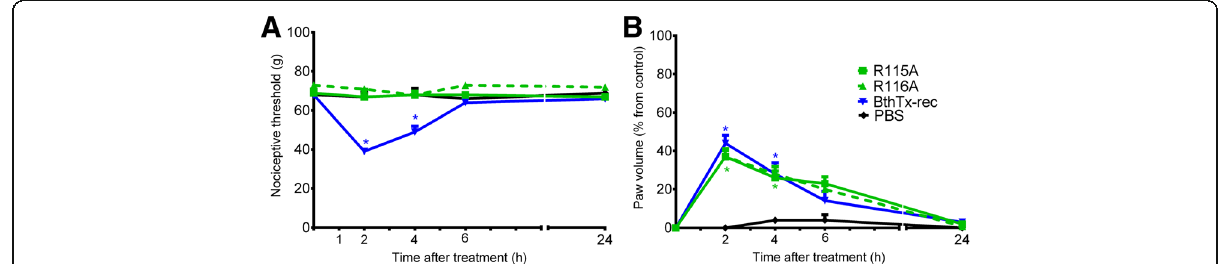
Fig. 3 Effect of BthTx-I K115A and K116A (Lys115 → Ala and Lys116 → Ala) mutagenesis on rat pain threshold and paw volume. Decrease in a threshold response and b paw volume were determined in rat hind paw before and 2, 4, 6 and 24 h after the intraplantar injection of PBS (control group) or R115A, or R116A, or recombinant BthTx-I. Sensitivity to pain was measured as the threshold response to pressure and expressed as g . The paw volume was obtained pletsmografically. Each point represents the mean±SEM of six animals. *Significantly different from mean values before venom injection ( p< 0.05)